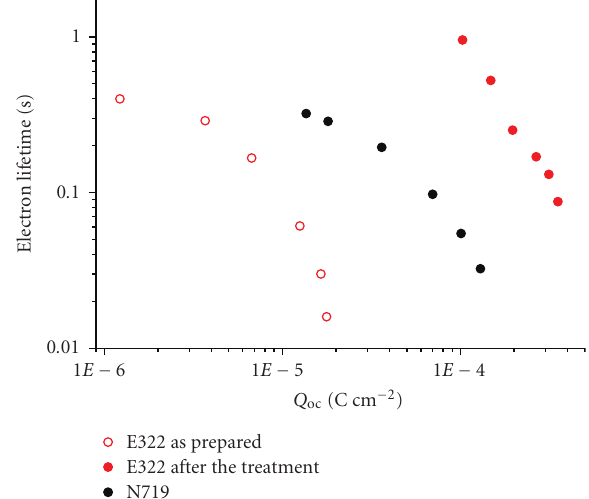
Figure 8: Electron lifetime as the function of the charge at open circuit condition, measured for the cell with E322 before/after the UV-treatment and the cell with